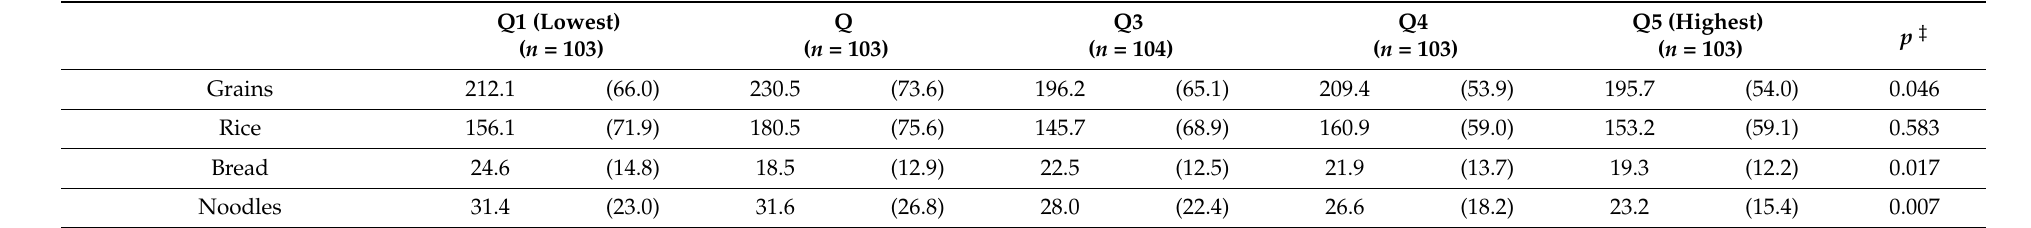
Table 3. Daily food group intakes according to quintile of milk intake of 516 female junior high school students (g/4184 kJ) †